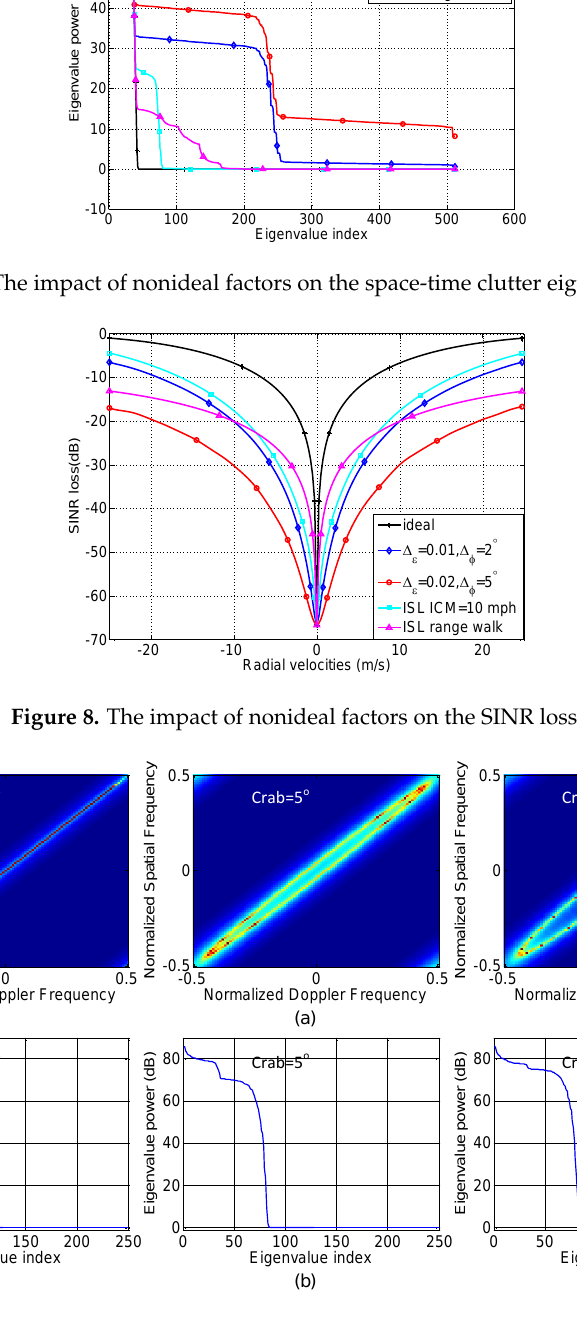
Figure 9. Effect of crabbing on ( a ) angle-Doppler image clutter; ( b ) eigenspectra,